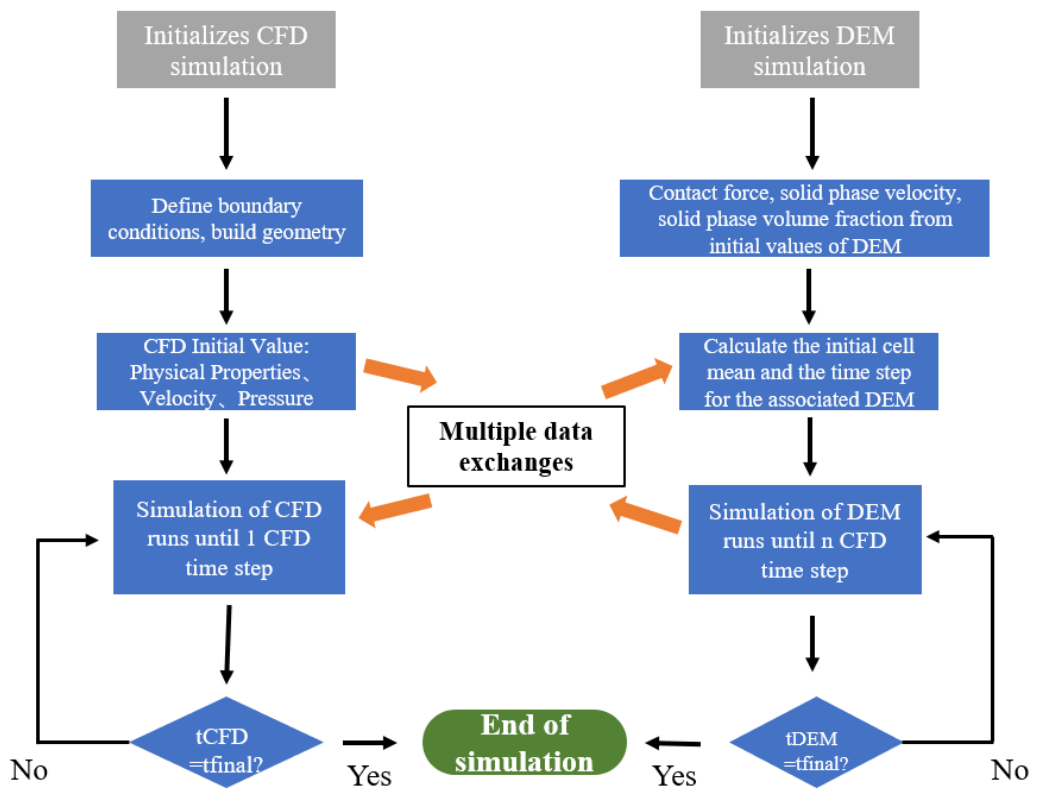
Figure 3. Schematic diagram of CFD–DEM coupling technique.